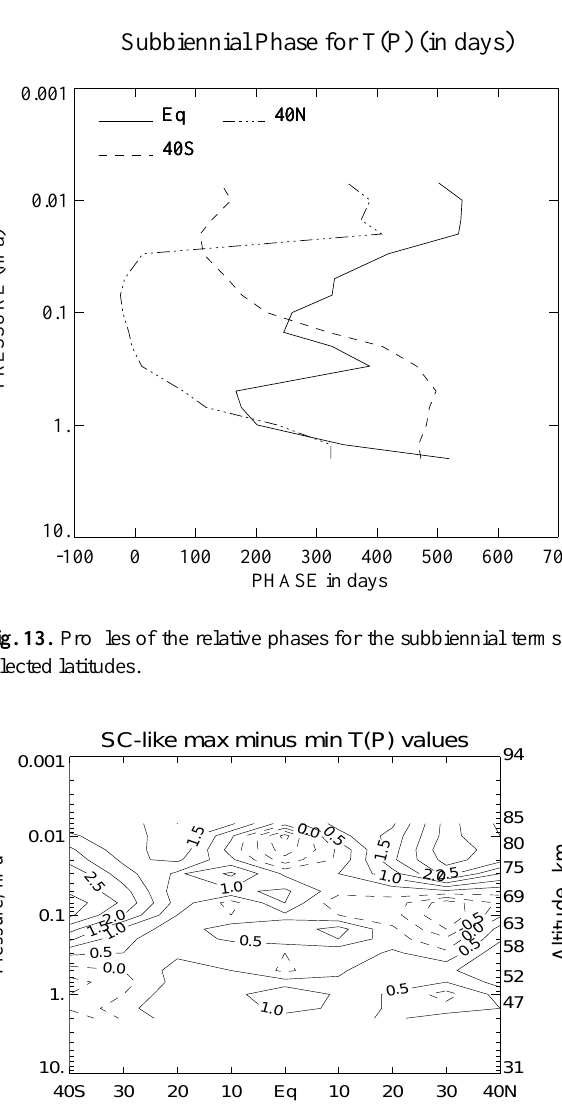
Fig. 14. Contour plot of the adjusted, SC-like “max minus min” T (p) values. Contour interval is 0.5K, and the zero and negative contours are